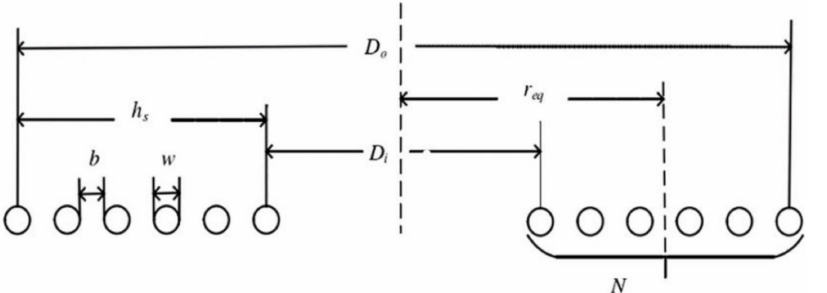
Figure 3. The cross-section of the planar spiral coil. The Di is the inner diameter; the r eq is the equivalent radius of the coil; the h s is the width of the coil.